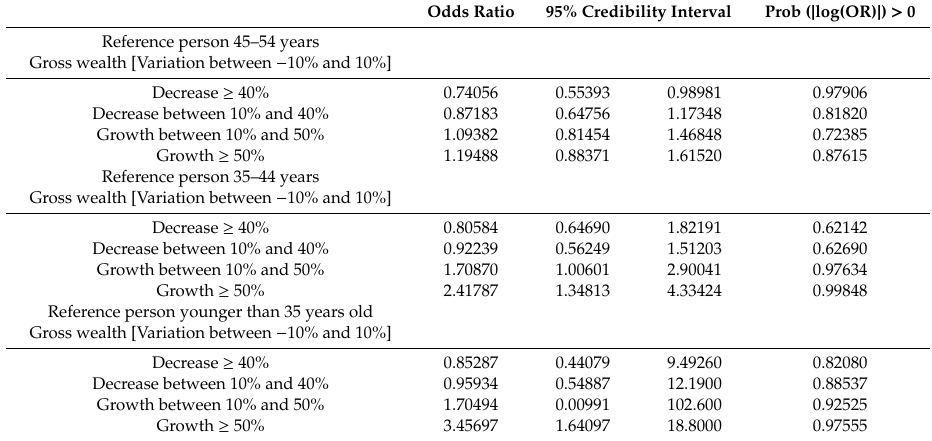
Table8. Associationbetweenthevariationingrosswealthandgoodandverygoodself-perceivedhealth. Odds